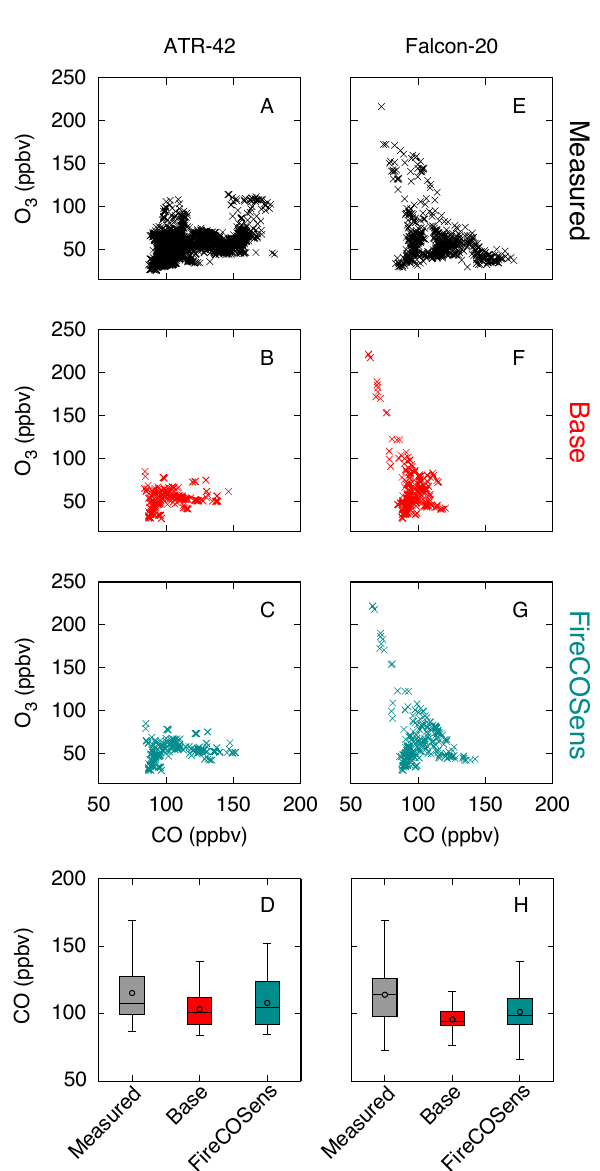
Fig. 7. Ozone versus CO correlations for the ATR-42 (a) and Fig. 7: Ozone versus CO correlations for the ATR-42 ( a ) and Falcon-20 ( e ) data, model base run ( b Falcon-20 (e) data, model base run (b) and (f) and a model run with CO emissions from fires x2, FireCOSens (c) and (g) for ATR-42 and f ) and a model run with CO emissions from fires x2, FireCOSens ( c and g ) for ATR-42 flights flights on 5, 7 and 8 July 2008 and Falcon-20 flights on 4, 7 and 8 on 5, 7 and 8 July 2008 and Falcon-20 flights on 4, 7 and 8 July. For comparison, model results July. For comparison, model results are extracted along the ATR- are extracted along the ATR-42 and DLR Falcon-20 flight tracks. Box and whisker plots for CO 42 and DLR Falcon-20 flight tracks. Box and whisker plots for CO (measurements, model base run, and FireCOSens run) are shown (measurements, model base run, and FireCOSens run) are shown in panels ( d ) and ( h ). For these in panels (d) and (h) . For these plots, the box indicates the 25% plots, the box indicates the 25% and 75% percentiles, the line represents the median, and the circle and 75% percentiles, the line represents the median, and the circle shows the shows the mean.